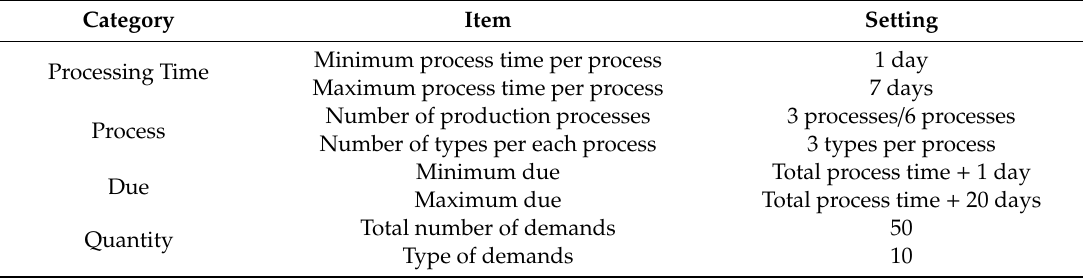
Table 5. Parameters of